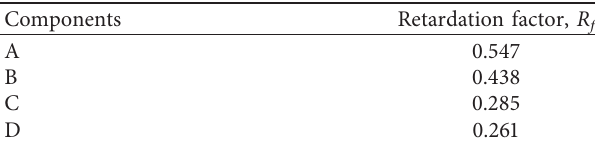
Table 9: Chromatographic separation of the fractions of constit- uents of methanol extracts of V. camporum.